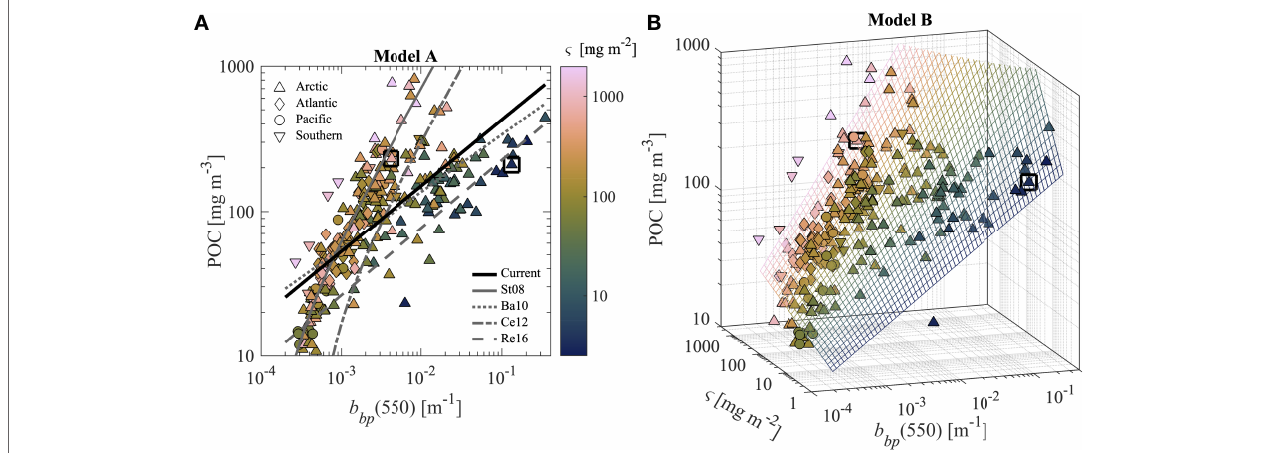
FIGURE 4 | Two regression models for estimating POC based on measurements of b bp at λ = 550 nm. (A) POC as a function of b bp (550) color coded by composition value ς . A linear regression trendline representing Model A from the current study is shown with a solid black line. Regression lines from other studies are indicated in legend where St08 denotes Stramski et al., 2008 ( λ = 555 nm), Ba10 denotes Balch et al., 2010 ( λ = 532 nm), Ce12 denotes Cetinic´ et al., 2012 ( λ = 532 nm), and Re16 denotes Reynolds et al., 2016 ( λ = 550 nm). Note that Re16 refers to the analysis of mineral-dominated particle assemblages and Ce12 refers to downcast and includes a factor of 0.88 to adjust b bp (700 nm) to the value at λ = 532 nm. (B) Three-dimensional scatter plot of POC, ς , and b bp , also color coded by ς value. A grid is used to show estimations from Model B. Two datapoints are marked with a square in all panels and represent samples which have similar POC but contrasting composition. N =